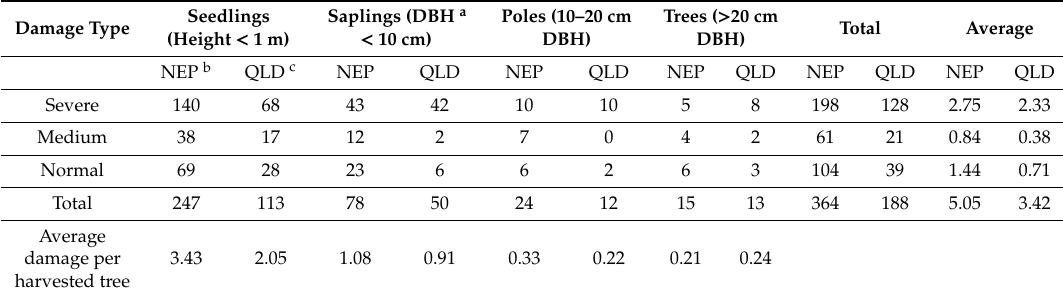
Table 7. Harvesting damage to surrounding tree species in Nepal and Queensland.